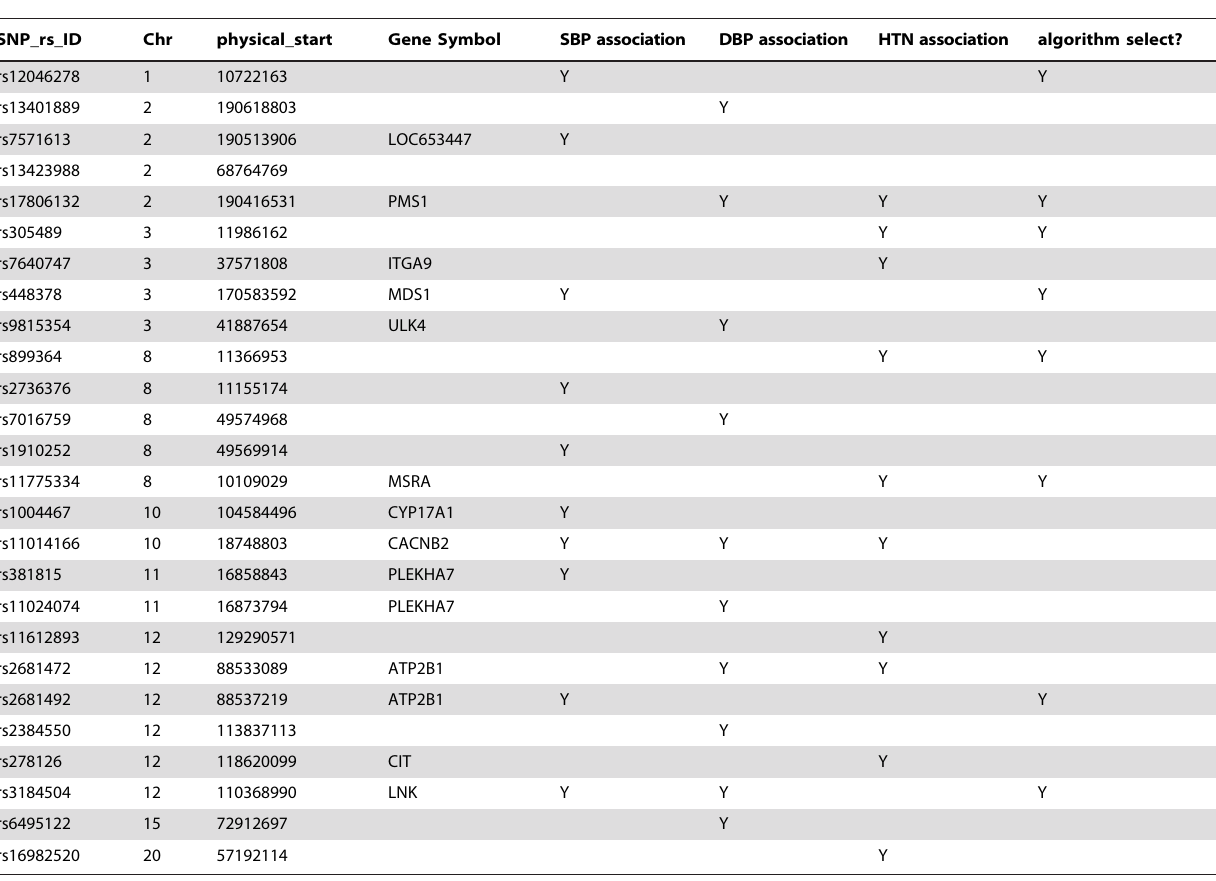
Table 3. List of candidate SNPs used for the analysis presented in the last set of Table